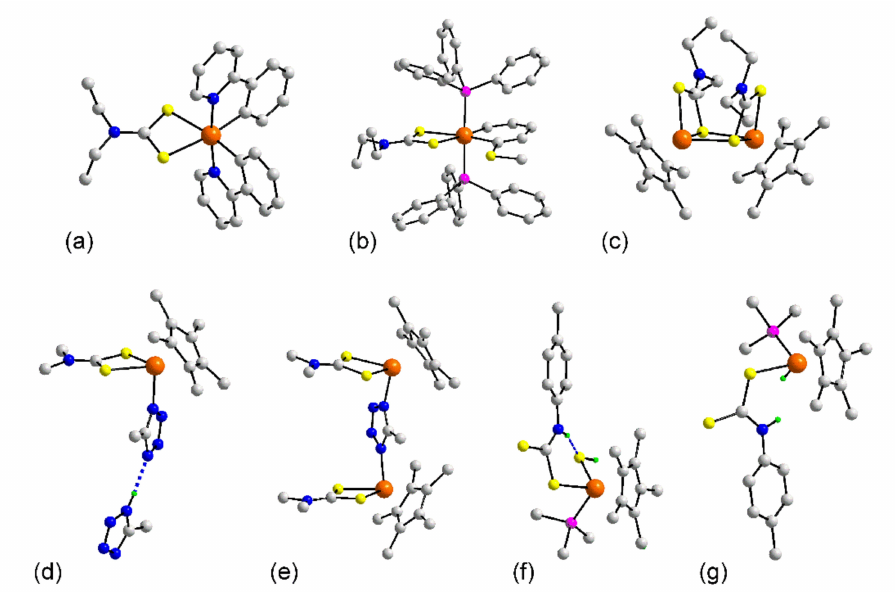
Figure 11. Molecular structures of iridium dithiocarbamate complexes: ( a ) Ir(ppy) 2 ( L 24 ) ( 177 ), ( b ) (PPh 3 ) 2 Ir(C 5 H 5 SMe)( L 24 ) ( 199 ), ( c ) [Cp*Ir( L 24 )] 22+ in the crystal of 204 , ( d ) Cp*Ir(mtz)( L 8 ) in 205 , ( e ) [{Cp*Ir( L 8 )} 2 (mtz)] + in 206 , ( f ) Cp*Ir(PMe 3 )( L 5 )(SH) in 207 , and ( g ) Cp*Ir(H)(PMe 3 )( L 5 ) ( 208 ). In ( d ) and ( f ), the blue dashed line represents N–H ... N and N–H ... S hydrogen bonds,